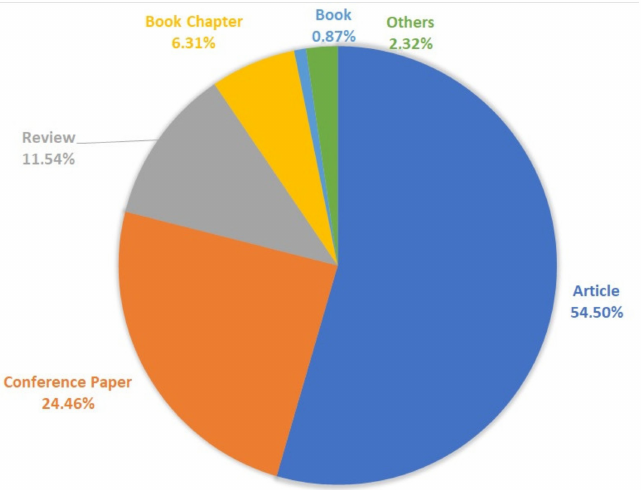
Figure 3. Renewable energy and agriculture document types for 2019–2021.